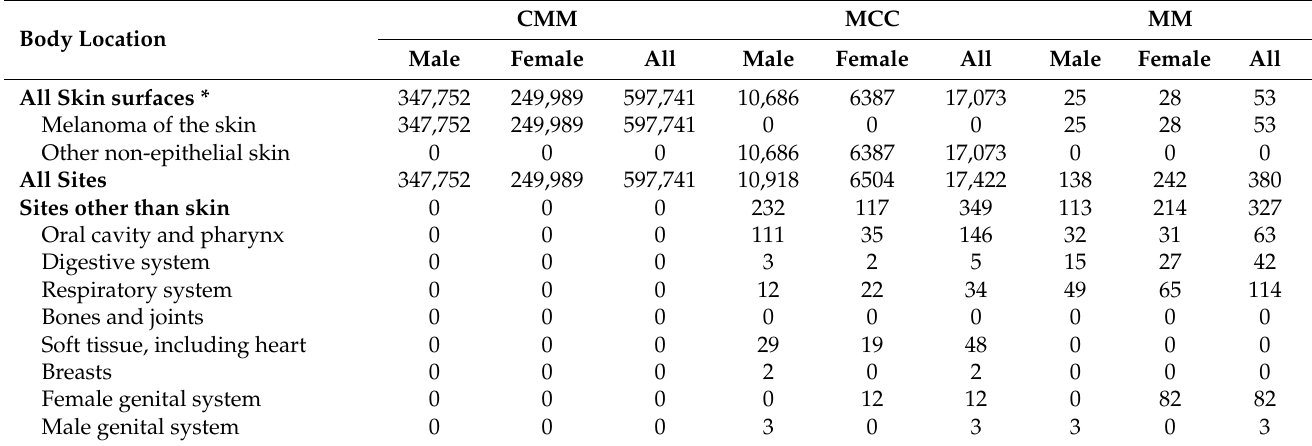
Table 1. Locations of malignant melanomas and Merkel cell carcinoma on the bodies of patients in 22 cancer registries in SEER